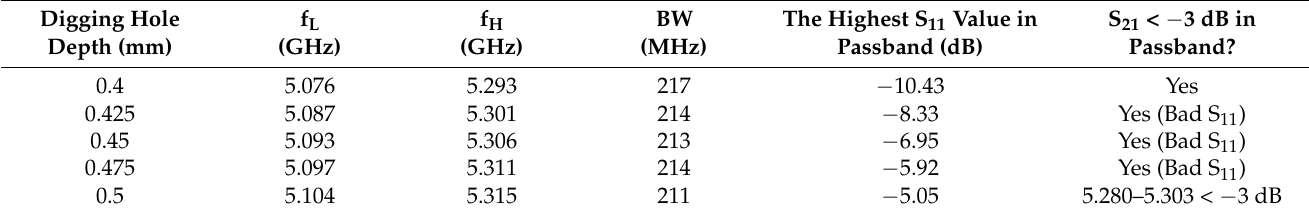
Table A4. The simulation results obtained with a fixed digging depth of 0.15 mm and various digging radii. Digging